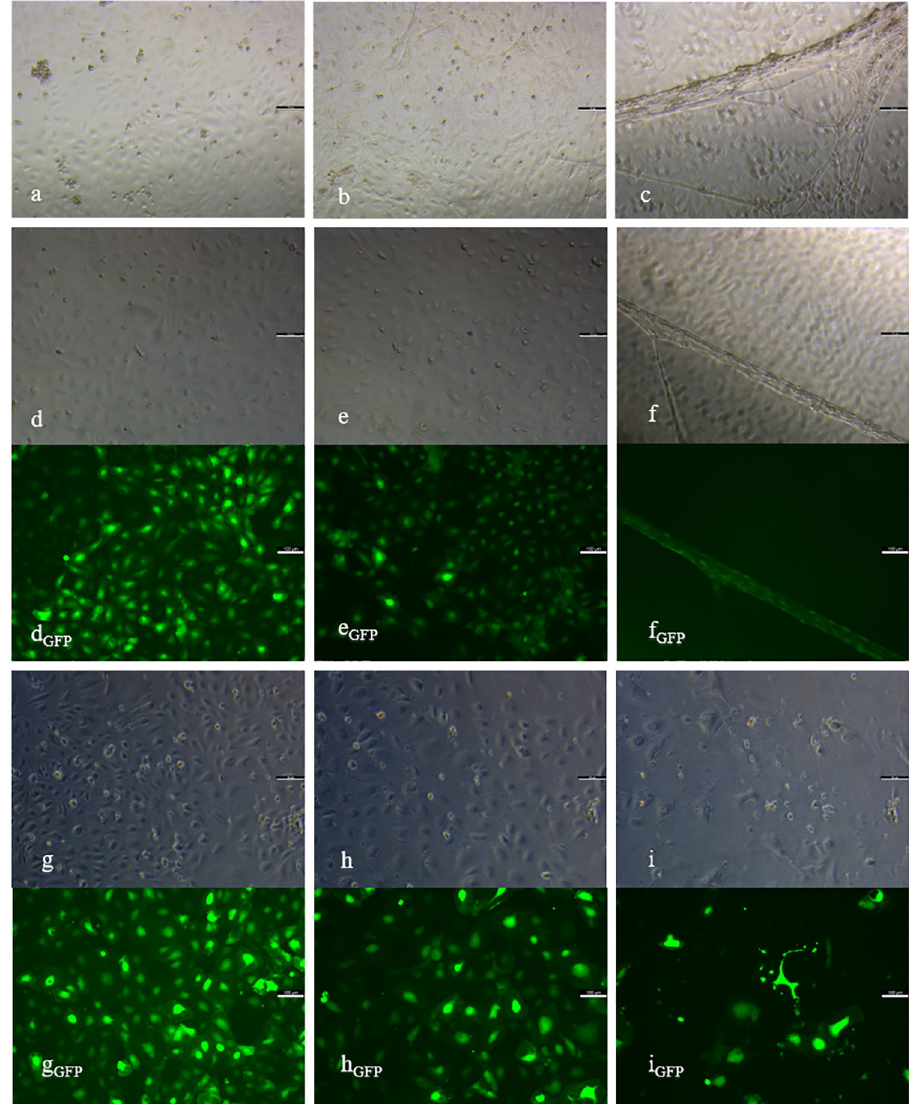
Fig 3. Angiogenesis in vitro of ECs of HD2. Native (a-c), control (d-f) and knockdown group (g-i) of HD2 including eGFP control of SCR 2 (d GFP , e GFP , f GFP ) and sh 2 (g GFP , h GFP , i GFP ) at day 5 (a, d, d GFP , g, g GFP ), 25 (b, e, e GFP , h, h GFP ) and 50 (c, f, f GFP , i, i GFP ) of cultivation. Elongated shaped cells of stage 2 (a, d, g) in all groups at day 5, was followed in N 2 and SCR 2 by networking (b, e) and three-dimensional organisation in stage 5–6 (c, f). The knockdown group showed a persistent decrease in cell density (h, i). Control group showed positive eGFP control during the investigation period (d GFP , e GFP , f GFP ), whereas sh 2 displayed a reduction in fluorescent signals (g GFP , h GFP , i GFP ). Scale bars = 100 μ